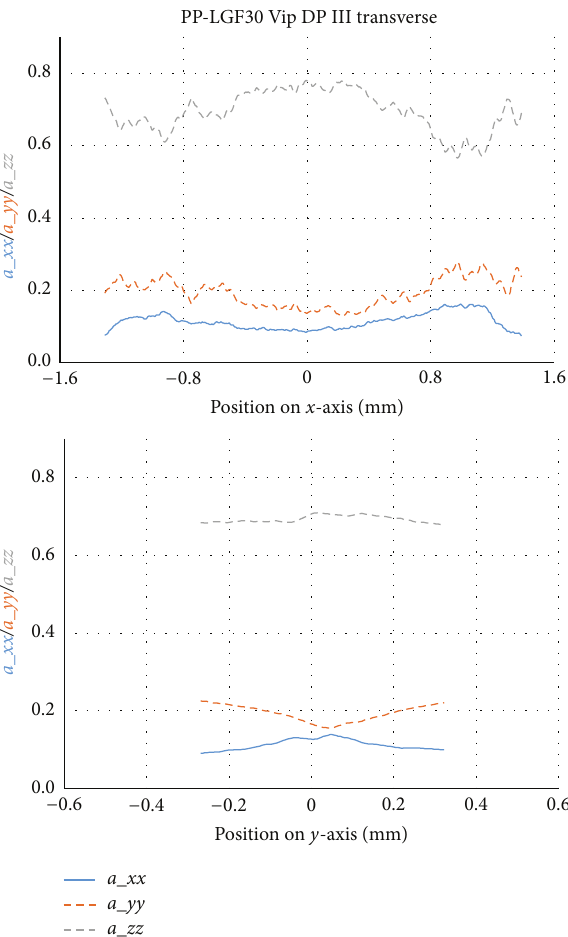
Figure 26: Progress of the fiber orientation along the 𝑥 - and 𝑦 -axis in the weld of two plates in vibration welding of PP-LGF30 with initial fiber orientation being longitudinal to the joining direction.